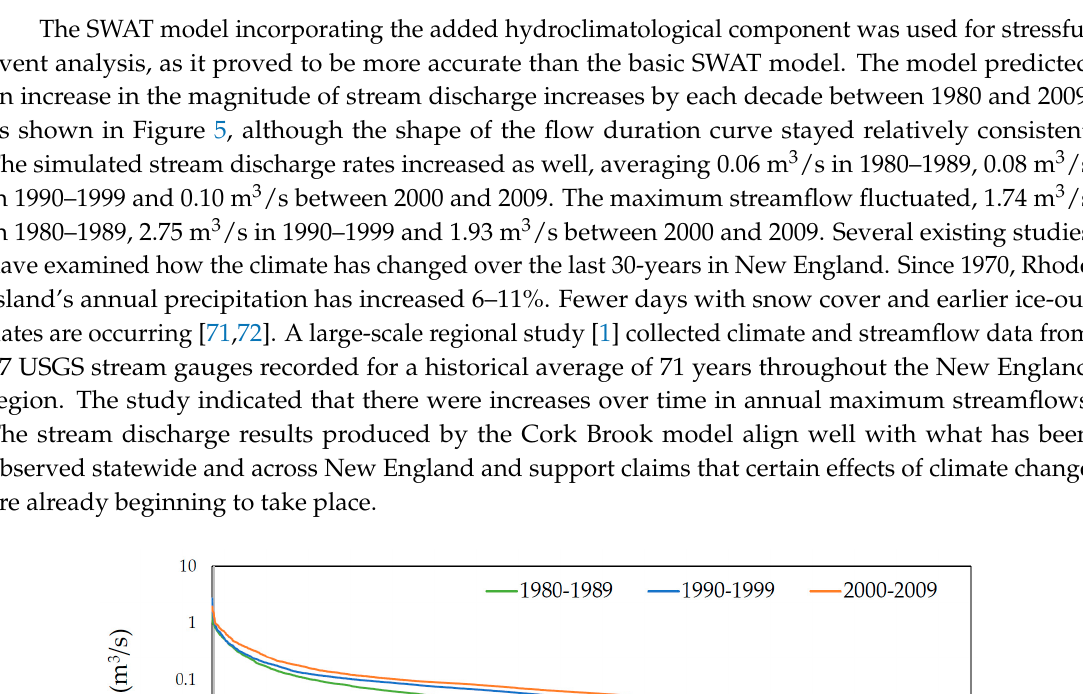
Figure 4. The number of days per month that stream temperatures exceeded the stress threshold of 21 °C during the stream temperature calibration and validation periods (2010–2013).